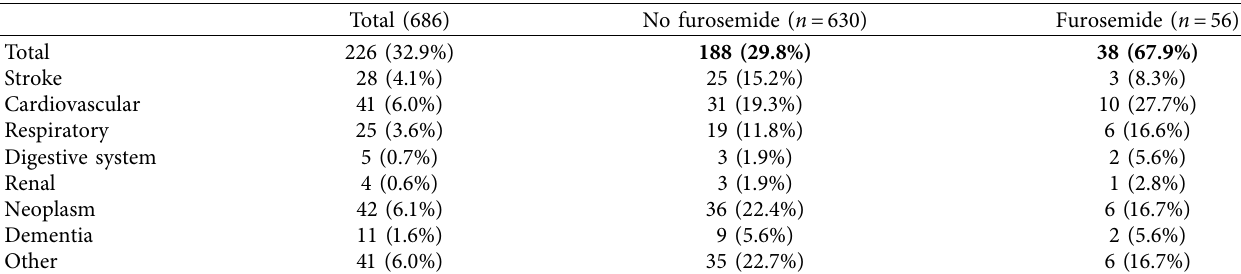
Table 2: Total number of deaths and causes of